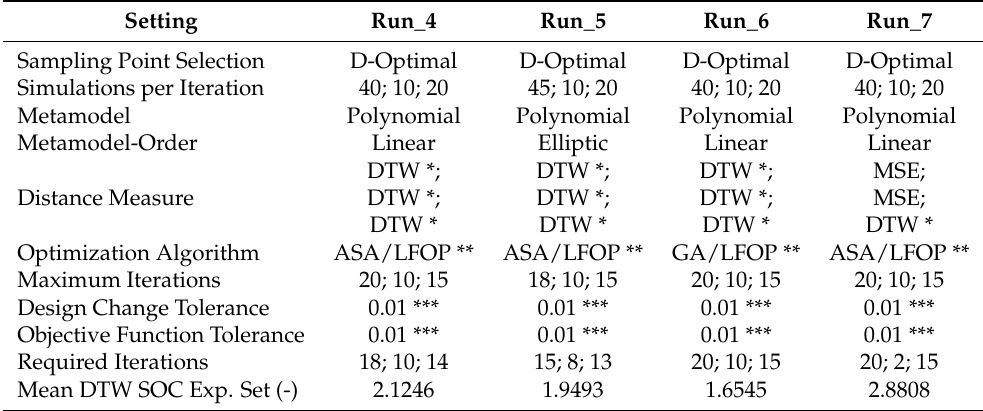
Table A2. LS-OPT settings of 3 Step Strategy for iterative optimization-based calibration and results (*—except for PEC Compression Test; **—when global optimum is found, switch to LFOP to find best local optimum; ***—default).